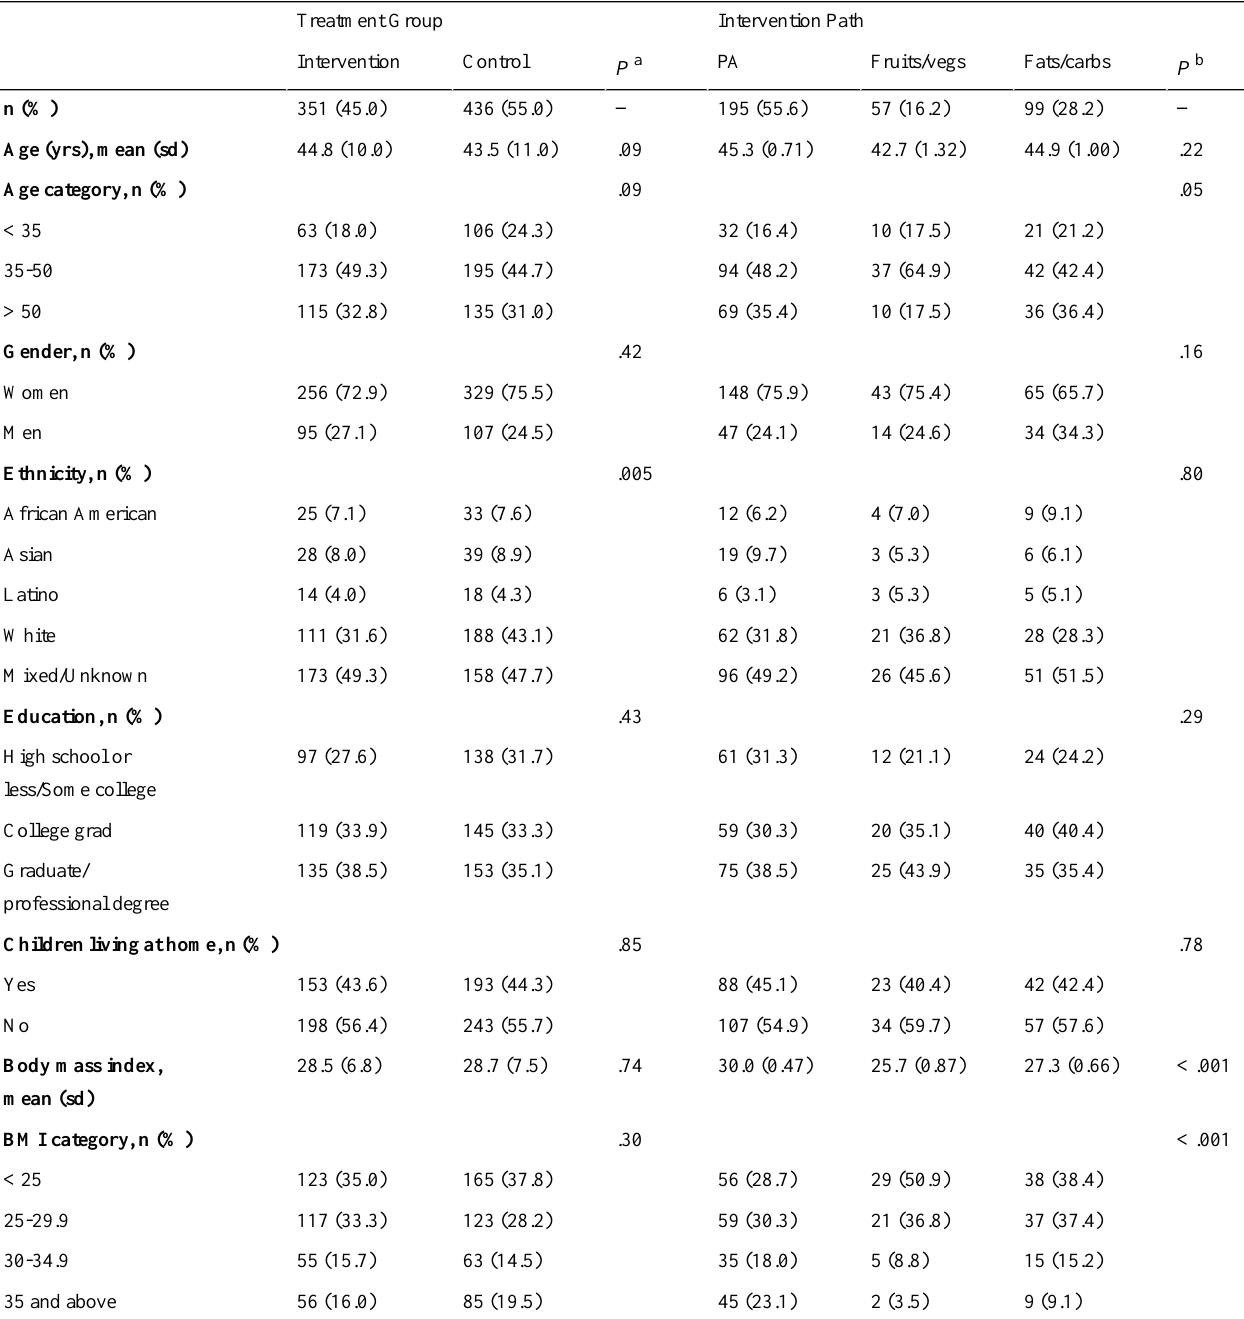
Table 2. Demographic characteristics by treatment group and by intervention path (Alive! randomized trial, Oakland, CA 2006)